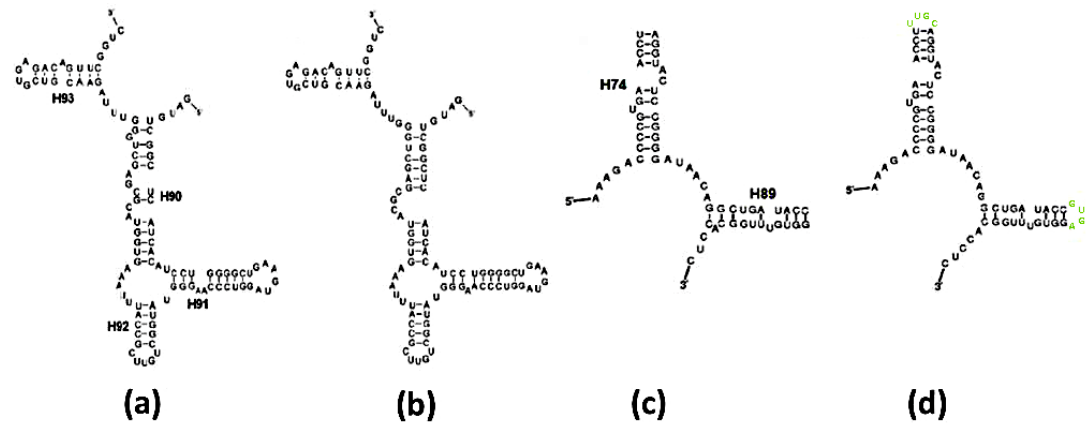
Figure 3. Ribosomal vs. predicted secondary schemes: ( a ) Scheme of the A-ext-SymR monomer from E. coli ; ( b ) Mfold prediction of the sequence in ( a ); ( c ) Scheme of the P-DPR monomer from E. coli ; ( d ) Mfold prediction of the sequence in ( c ), with stem loops artificially appended to the truncated H74, H89 (in lime) to obtain an intact